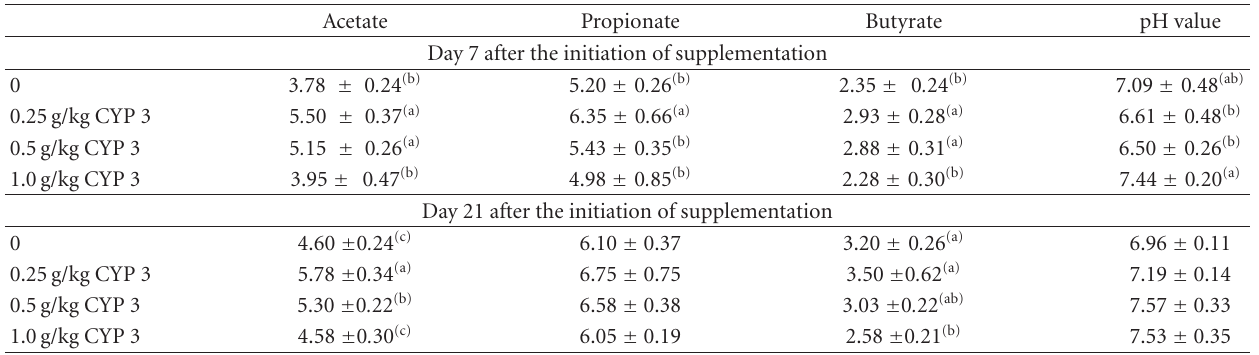
Table 6: Contents of short-chain fatty acids and pH value in cecum in weaned rats ( µ mol/g, n = 4).